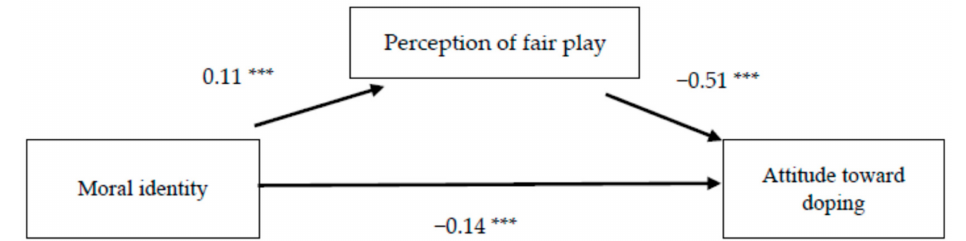
Figure 1. The effects of moral identity on attitudes to doping and the mediating role of perception of fair play among athletes. Note: The values presented are the unstandardized regression coefficients. A solid line represents a significant relationship. *** p < 0.001.